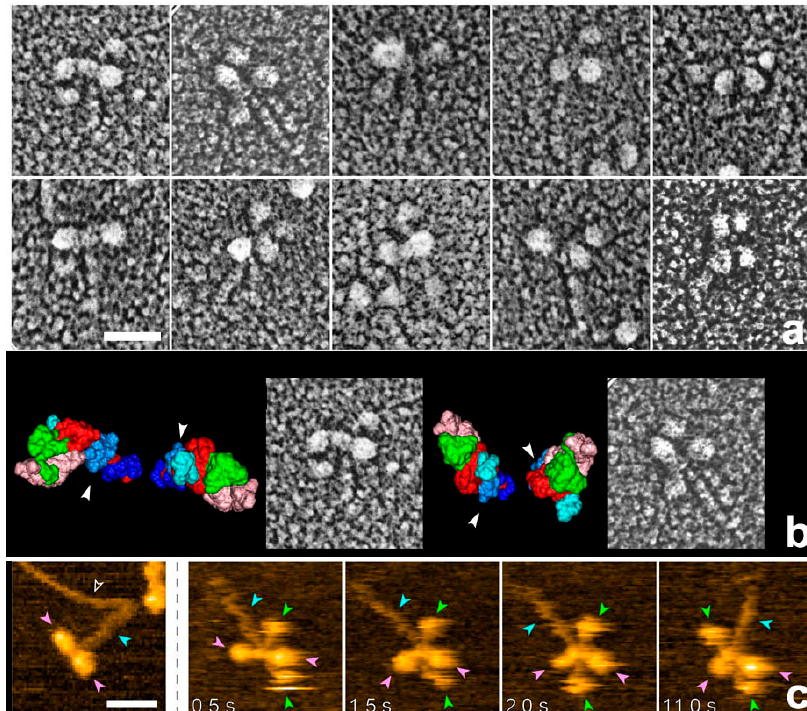
Figure 7. Gallery of QFDE replica and HS-AFM images of HMM whose light chains were tagged with some rod-shaped marker proteins [45]. Use of such judicious markers might effectively help complementing the intermediate spatial resolution of those methods. ( a ) QFDE replica images of several particles; ( b ) Two particles aligned with respective model-views to exhibit their subdomain arrangements. White arrowheads indicate the position of the N-terminus for each head; ( c ) HS-AFM images of the same materials naturally share a similar morphology. The leftmost image indicates non-labeled myosin. Pink, green and blue arrowheads represent myosin head, marker and subfragment-2, respectively. Scale bars indicate 30 nm. This construct was kindly produced and provided by Prof. T. QP Uyeda (Waseda University).